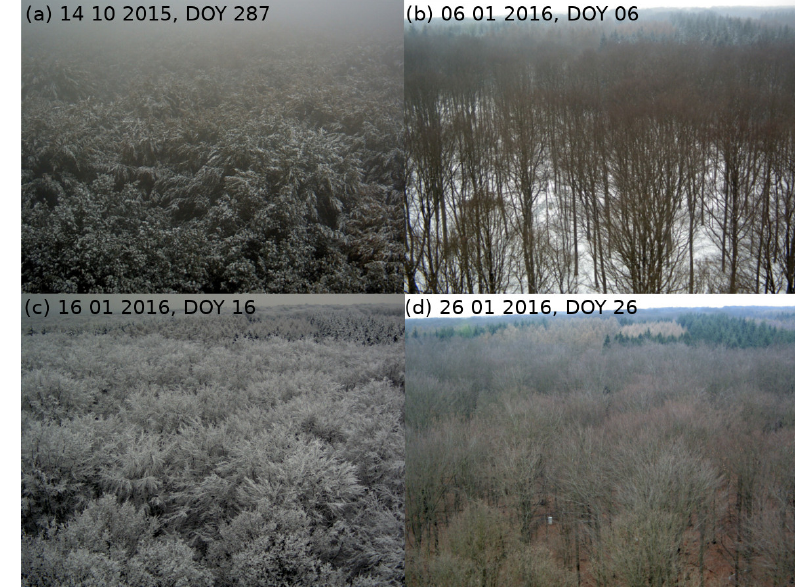
Figure 5. Pictures of the area around the eddy flux tower ‘Hohes Holz’. ( a – d ) are captured at different dates, ranging from 14 October 2015–26 January 2016. ( a ) shows the canopy covered by snow and ice in fall 2015. ( b ) shows snow cover of soil seen through a leafless tree canopy. In ( c ), the tree canopy is covered by ice, while ( d ) shows the area after a melting event (no snow or ice left). The initial NDVI increase in 2016 (March) was captured by all systems almost